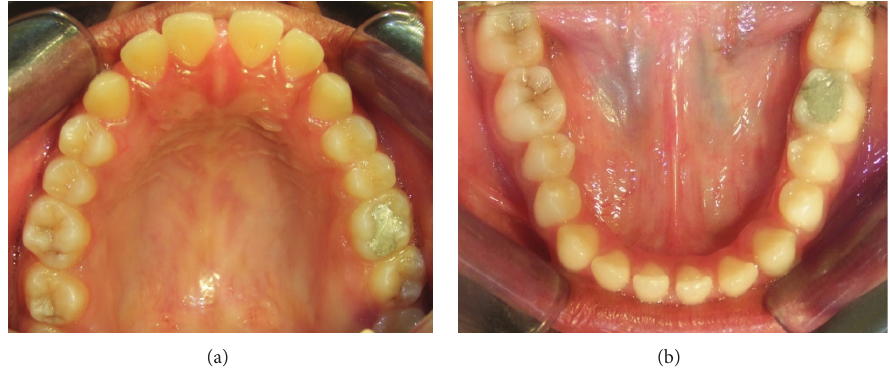
Figure 4: Pretreatment: (a) upper, and (b) lower